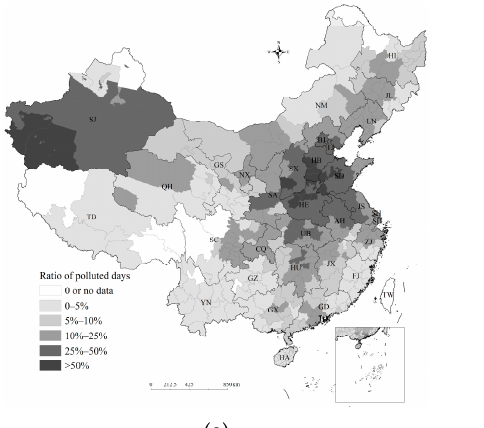
Figure 2. Search index and PI of haze and ozone in China: ( a ) haze search index; ( b ) PI haze ; ( c ) ozone search index; ( d ) PI ozone .